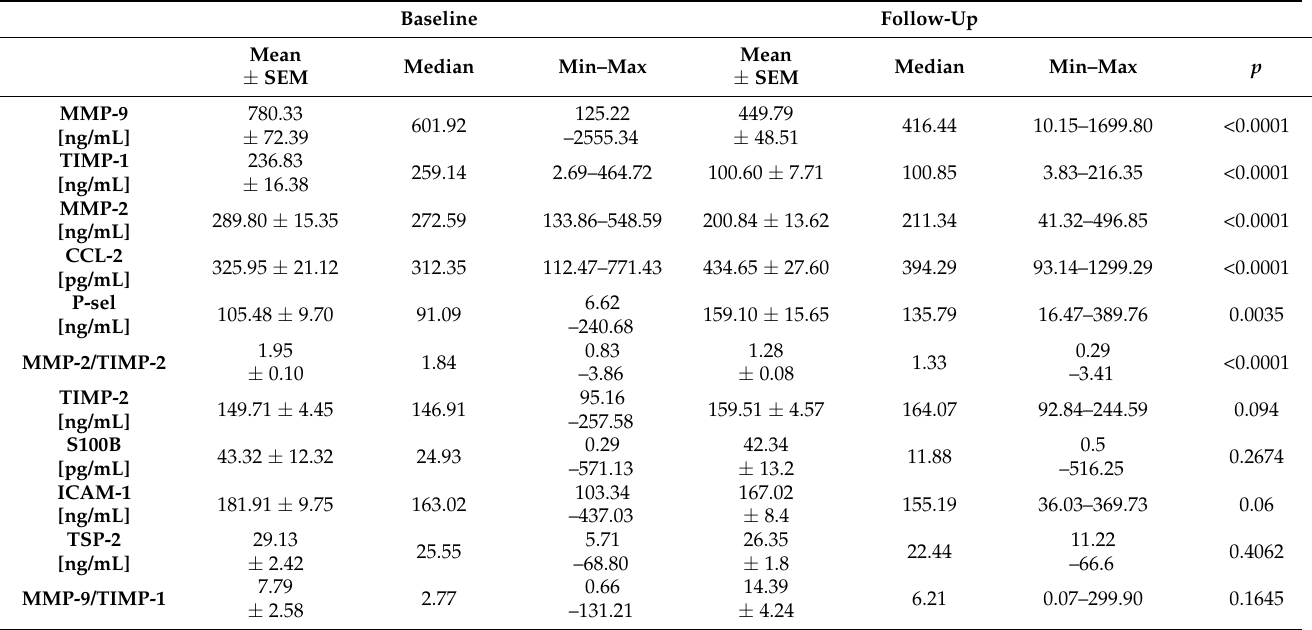
Table 9. Levels of the examined molecules at baseline and